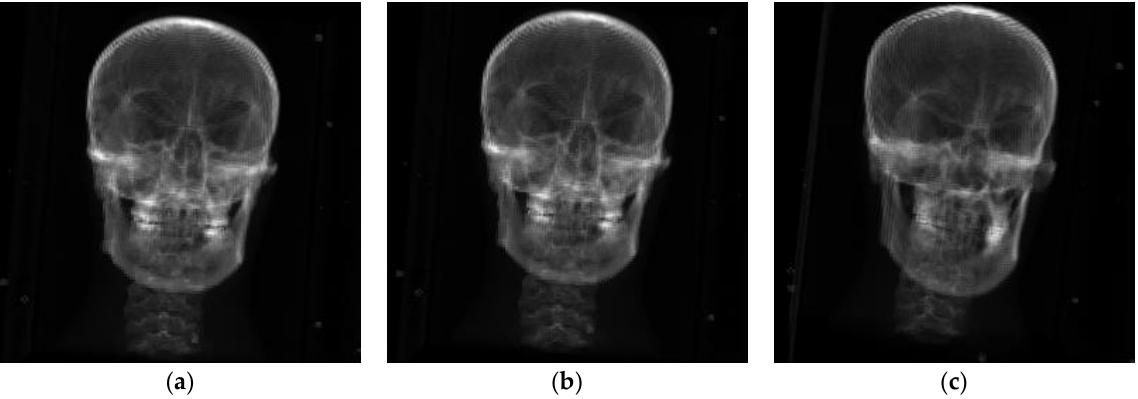
Figure 6. Experimental reference images. ( a ) Experiment 1 reference image; ( b ) experiment 2 refer- ence image; ( c ) experiment 3 reference image.